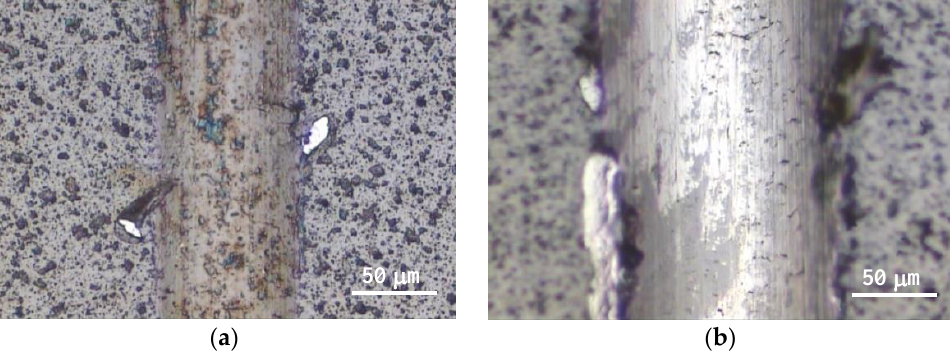
Figure 11. Friction force ( F t ) and acoustic emission (AE) as a function of the load ( F n ) for AlCrN + CrCN coating.